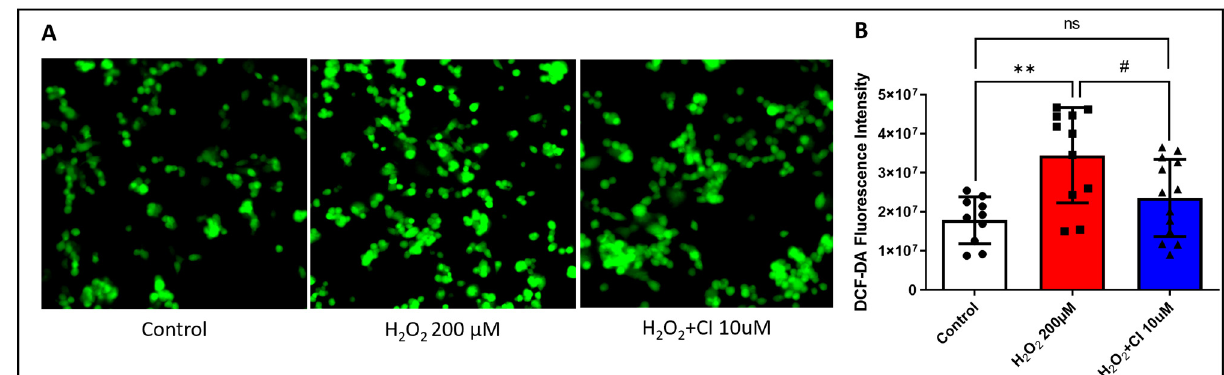
Figure 3. The effect of H 2 O 2 stimulation and CI treatment on SH-SY5Y cell viability and cofilin sig- naling. ( A ) SH-SY5Y cells were treated with increasing concentrations of H 2 O 2 for 24 h followed by the CCK8 viability assay to measure the neurotoxic potential of H 2 O 2 . SH-SY5Y cell viability was significantly reduced with concentrations of 100, 150, and 200 μ M of H 2 O 2 . ( B ) SH-SY5Y cells were treated with 200 μ m H 2 O 2 alone or with an increasing concentration of CI for 24 h, and cell viability was measured using the CCK8 assay. Cell viability was significantly reduced in the H 2 O 2 -treated group; however, treatment with 5, 7, and 10 μ M CI significantly protected the cells from the H 2 O 2 - induced neurotoxic effect. ( C , D ) The expression level of cofilin and p-cofilin was tested by WB. H 2 O 2 significantly reduced the p-cofilin expression and increased cofilin dephosphorylation, which was rescued by CI treatment. Data are expressed as mean ± SEM of three independent experiments where p < 0.05 was considered significant. * p < 0.05, ** p < 0.01, **** p < 0.0001 relative to control group. # p < 0.05, ### p < 0.001 relative to H 2 O 2 group. (See Figure S3 for original Western blot images).